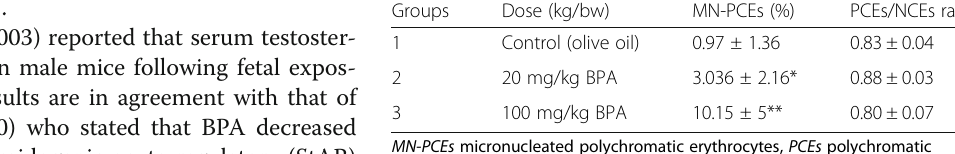
Table 4 Micronucleated polychromatic erythrocyte (MN-PCEs) in the bone marrow of male rats exposed to BPA